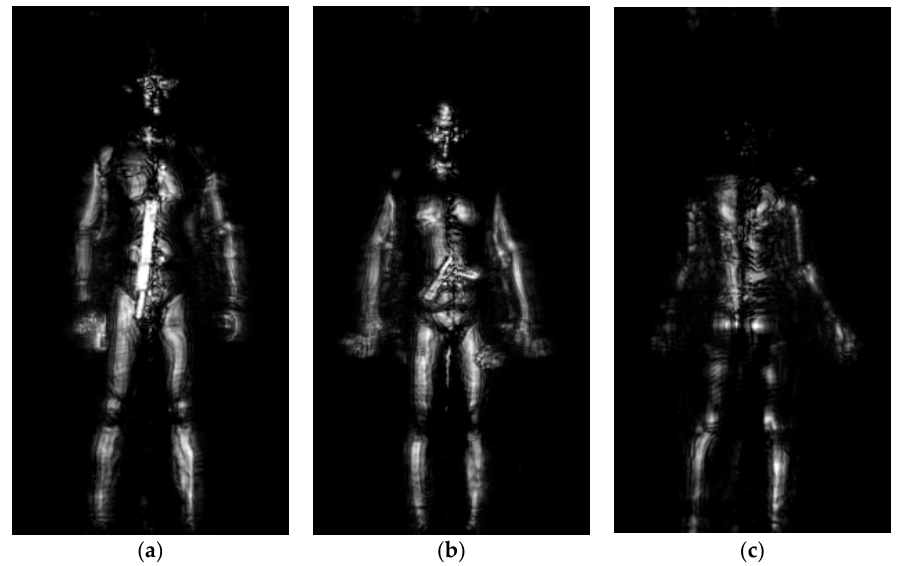
Figure 2. Terahertz human imaging results. ( a ) The image is imaging from frontal angles and the man in this image carried a long knife. ( b ) The image is imaging from frontal images and the man carried a metal simulation handgun. ( c ) The image is imaging from back angles and the man didn’t carry any targets.